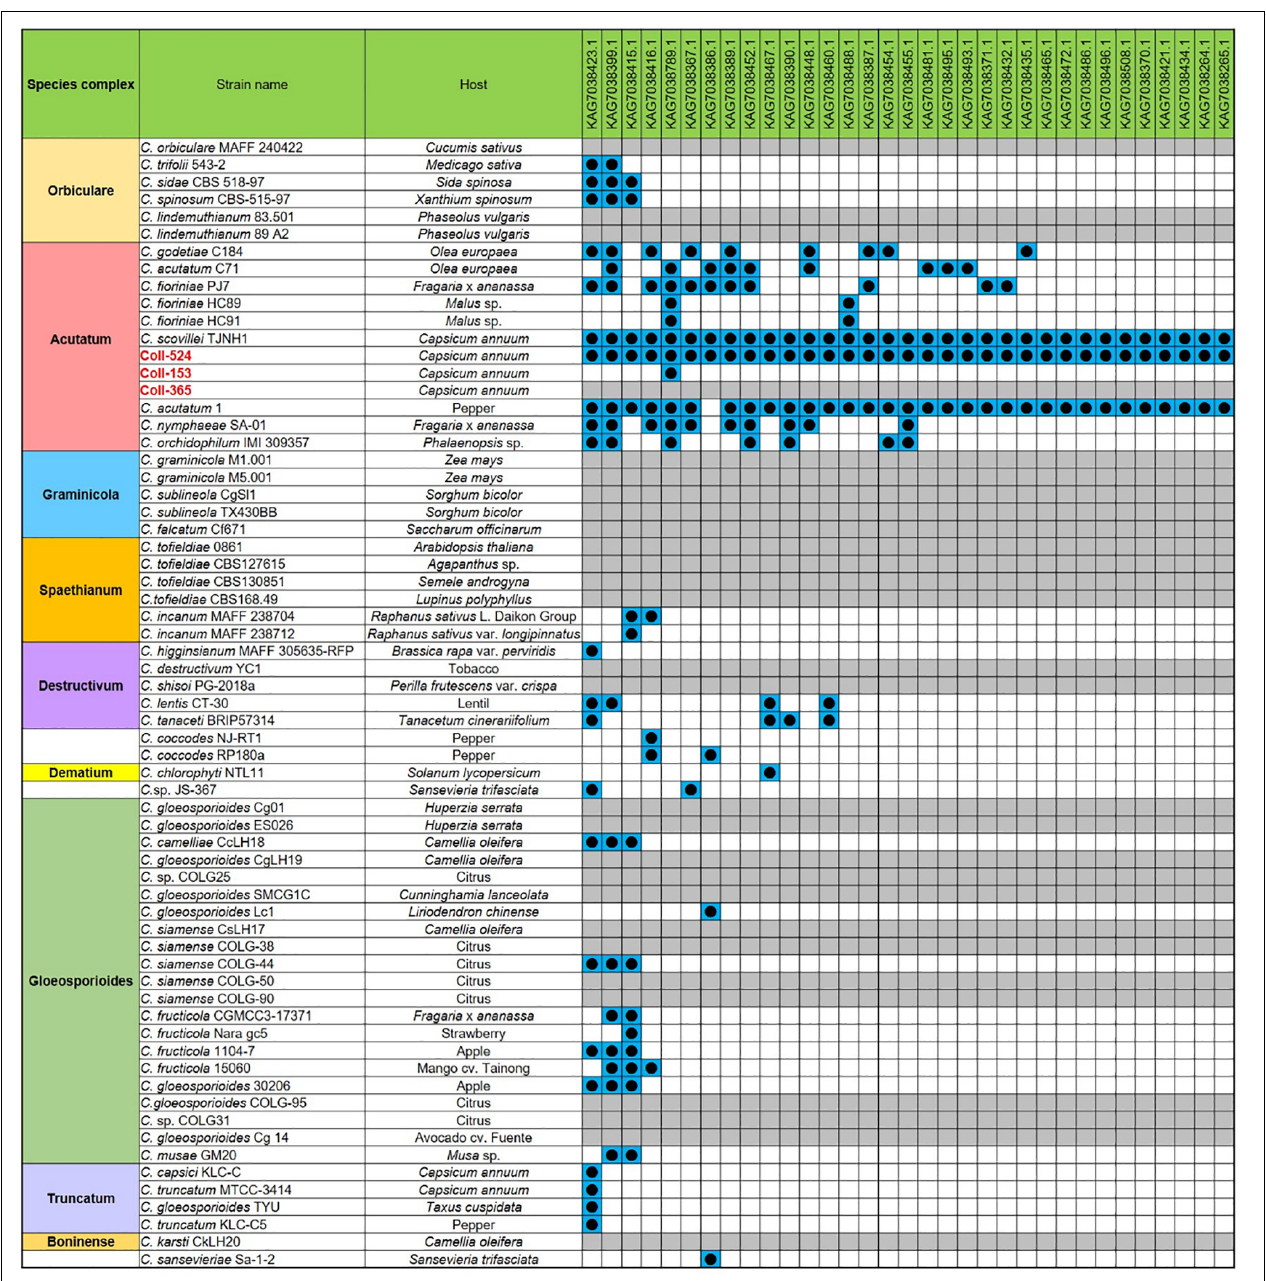
FIGURE 6 | The distribution of the 33 candidate effector genes in strains Coll-524, 153, and 365, and the 62 Colletotrichum strains with whole genome sequences deposited in NCBI. The 33 candidate effector genes were analyzed using nucleotide BLAST against the 62 genomes of Colletotrichum strains. Blue squares indicate the presence of genes by the blasting with coverage > 90% and identity > 60%. The gene was ordered from left to right by distribution frequency in the 62